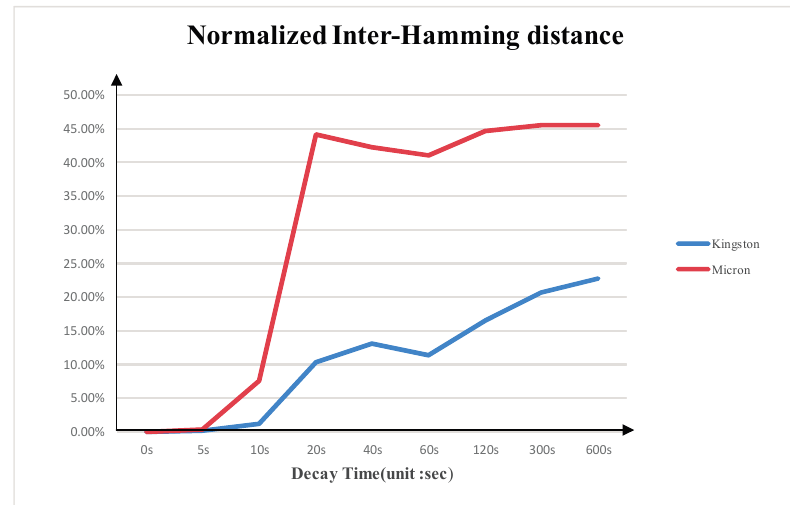
Figure 8. Normalized inter-Hamming distance between DDR3 devices with the same